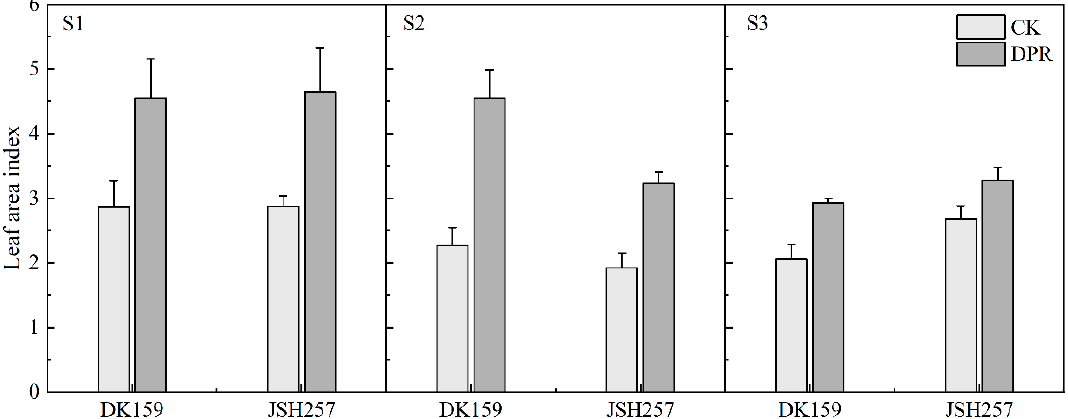
Figure 2. Effects of deep straw return on leaf area index during silking stage in saline land.